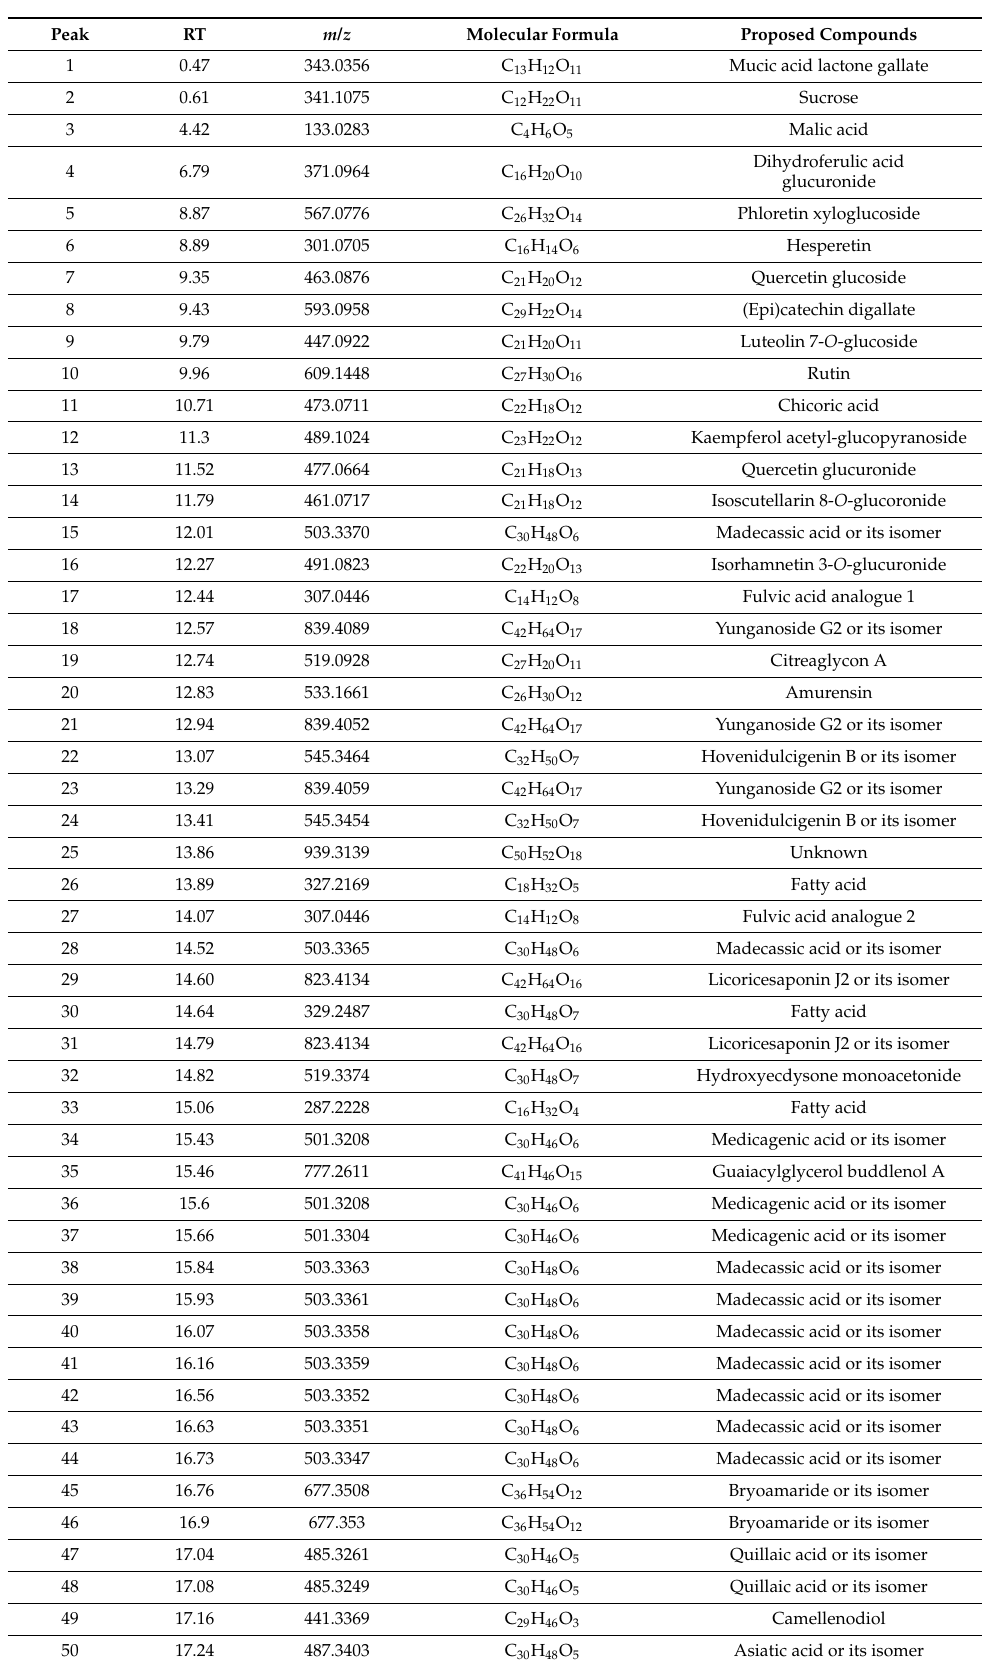
Table 1. Polar profile of